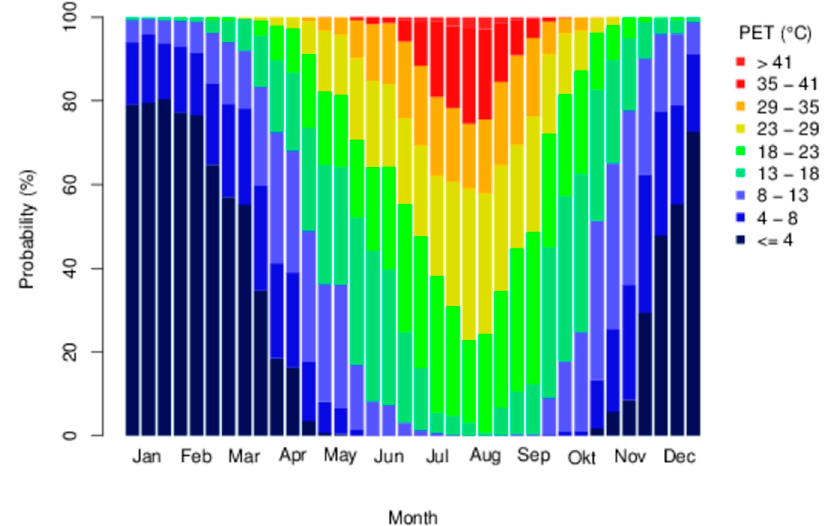
Figure 1. Decadal frequency diagram of PET classes for Tokyo based on data covering the period from August 1966 to June 2018 at a resolution of 3 h. Results are classified according to the thermal perception classes provided by Table 1 (modified after [29]).